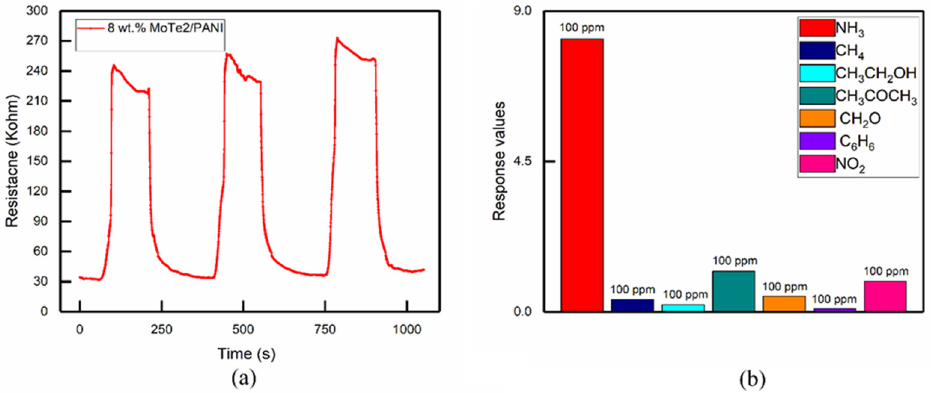
Figure 8. ( a ) Repeatability and ( b ) selectivity of 8 wt.% MoTe 2 /PANI composites gas sensor.